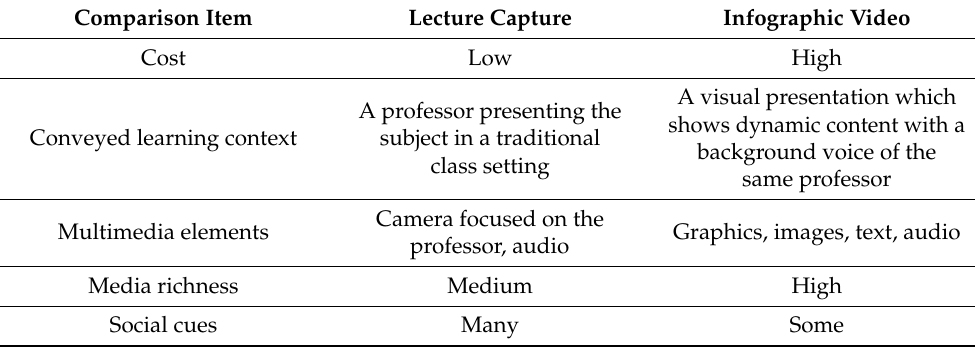
Table 1. Research stimuli in comparison.